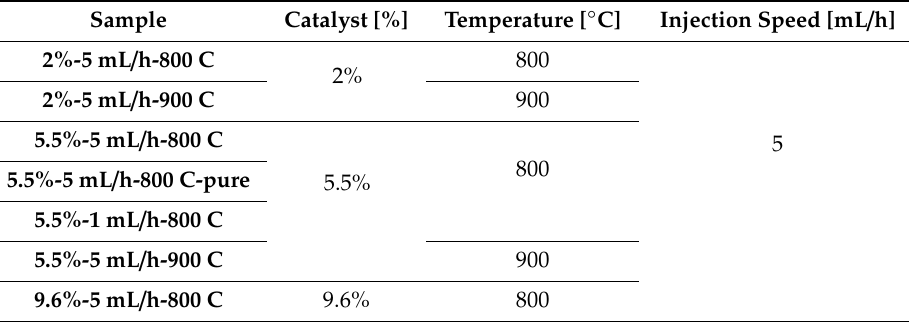
Table 1. Various synthesis parameters to obtain